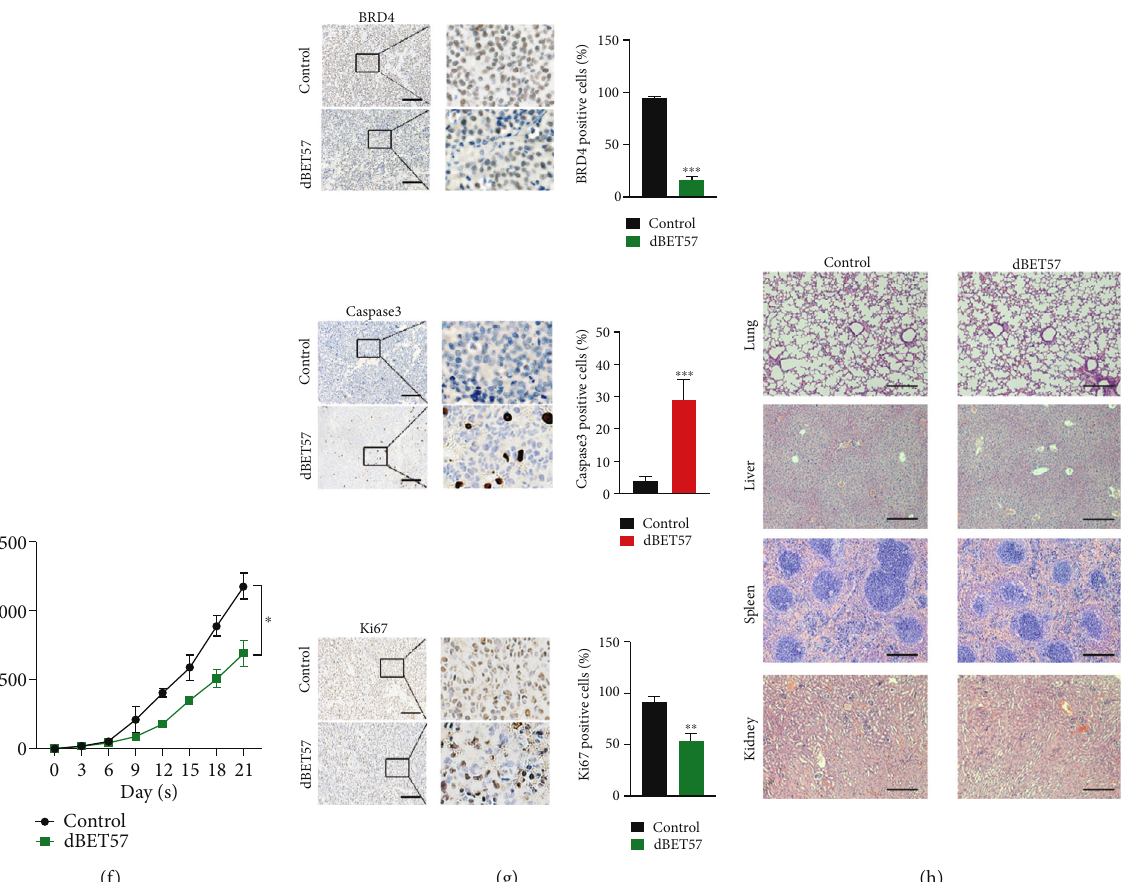
Figure 5: dBET57 exhibits tumor growth inhibition e ff ect in xenograft tumor model. (a) Flow chart of the xenograft tumor model. (b) Body weight curve of nude mice surviving 21 days. (c) Tumor signal values in nude mice. (d) Measurement of tumor size in control and experimental groups. (e) Statistics of the average weight of the two groups of tumors. (f) Tumor growth curves of experimental group and control group. (g) Immunohistochemistry of BRD4, Ki67, and Caspase3. Scale bars: 100 μ m. (h) Pathological sections of the kidney, liver, spleen, and lung. Scale bars: 100 μ m. The experimental group (intraperitoneal injection of dBET57) was compared with the control group. ∗ p < 0 : 05 , ∗∗ p < 0 : 01 , ∗∗∗ p < 0 : 001 ; ns: not signi fi